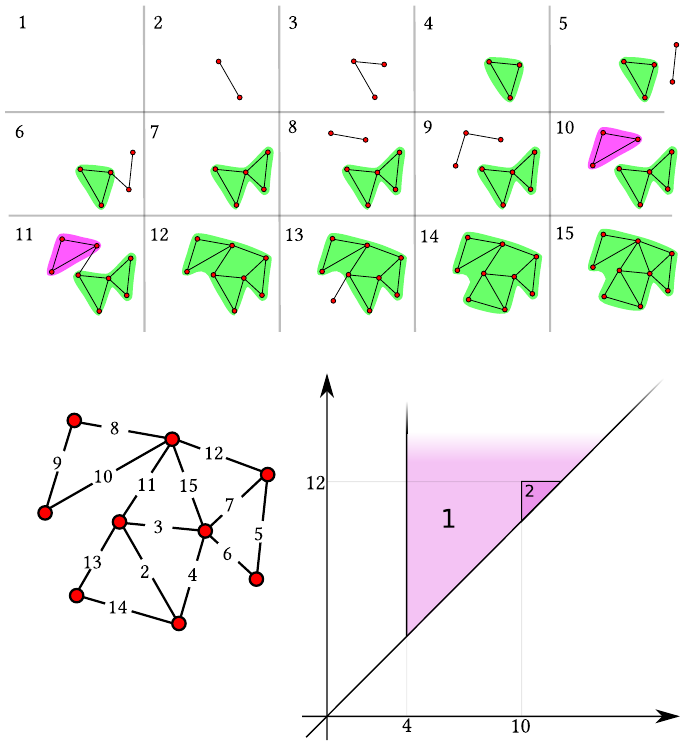
Figure 7. The weighted graph of Figure 1 (left), the corresponding filtration (above) and its 2-edge- block number